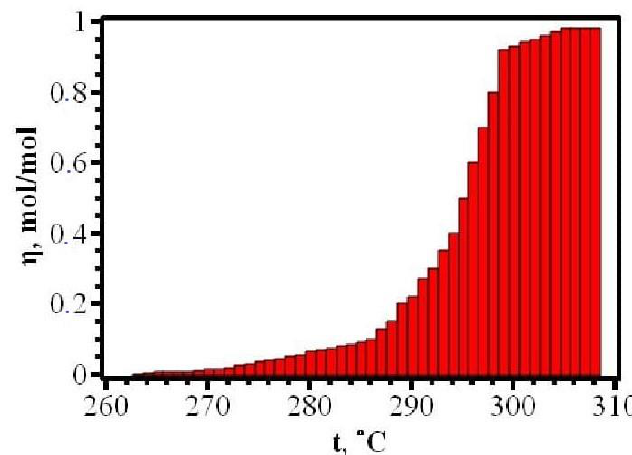
Figure 5. Dynamics of the degree of conversion of silver maleate.